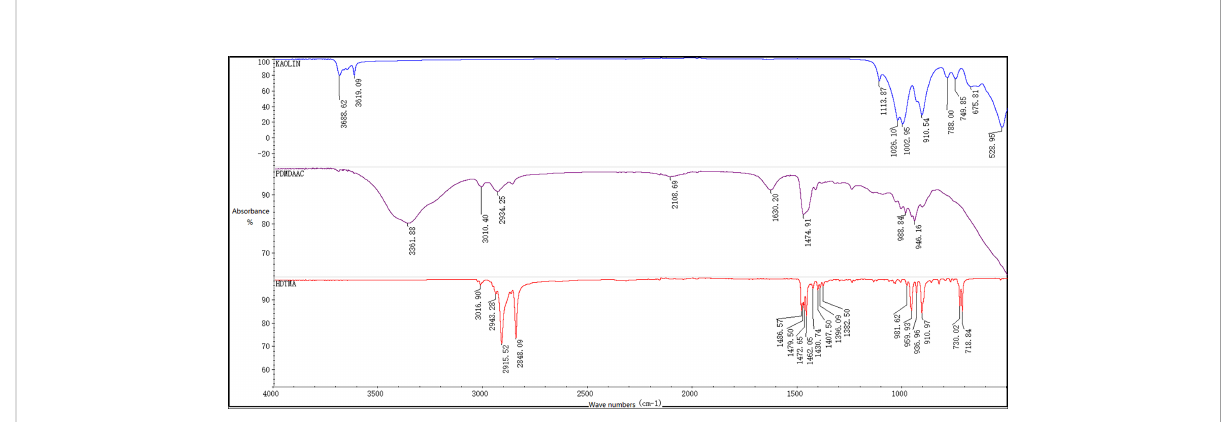
FIGURE 9 FT-IR spectra of kaolin, PDMDAAC and